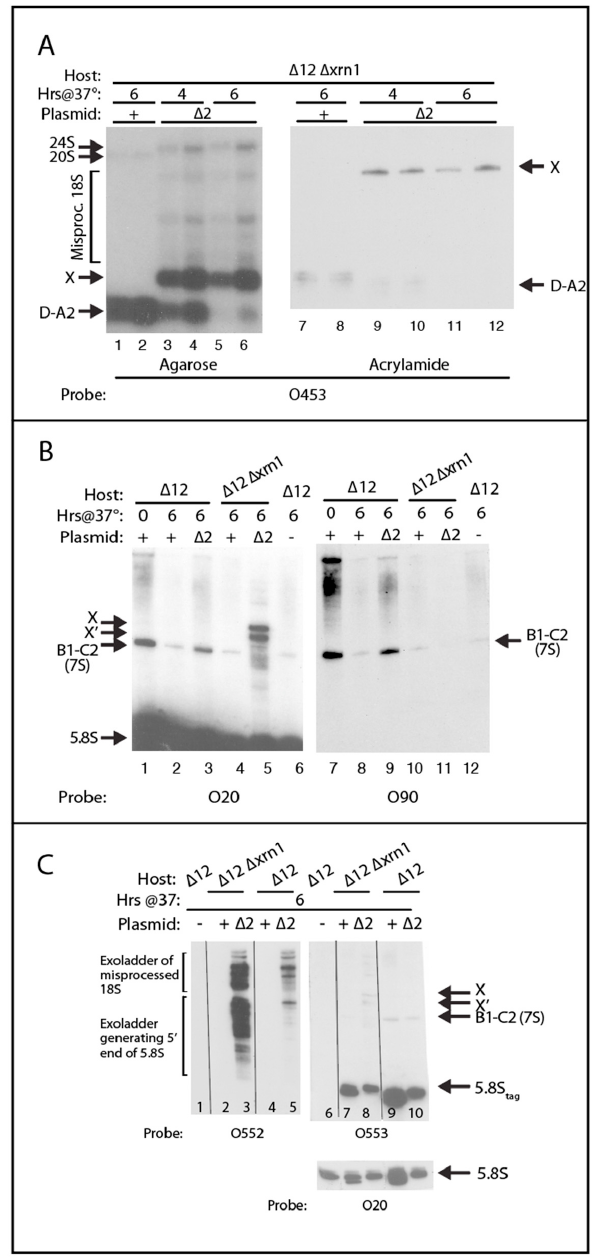
Figure 7. Characterization of intermediates in the processing of ∆ 2 pre-rRNA. Total RNA from ∆ rpa12 XRN1 or ∆ rpa12 ∆ xrn1 carrying pDK16-tag with wildtype or ∆ 2 rRNA genes was extracted from cells grown at 25° (time 0) or after cells were shifted to 37° for 4 or 6 h. The RNA was fractionated by agarose or acrylamide gel electrophoresis and analyzed by northern blots. ( A ) The wildtype D-A2 wildtype intermediate was replaced with a longer intermediate (X) in ∆ 2 processing. Agarose (left) and acrylamide gels (right) were blotted and probed with O453. ( B ) The X and X’ intermediates in processing of ∆ 2 pre-rRNA include the 3 ′ end of 5.8S rRNA. Acrylamide gels were blotted and probed with O20 or O90. ( C ) The ∆ 2 pre-rRNA processing intermediates were subject to exonuclease maturation. An acrylamide gel was blotted and probed with O552 (lanes 1–5), O553 (lanes 6–10), or O20 (5.8S slice of the blot showing the 5.8S bands in lanes 6–10). All images in panel ( C ) came from the same blot, probed sequentially and stripped in between each probing; see text for details. The blots in this figure were not cropped at the top or the bottom of the blot, except for the O20 loading control at the bottom right of the figure. Irrelevant lanes were cut out in panel ( C ) (indicated by the lines). The specificity of the O552 probe is also evident from the uncropped blot in Figure